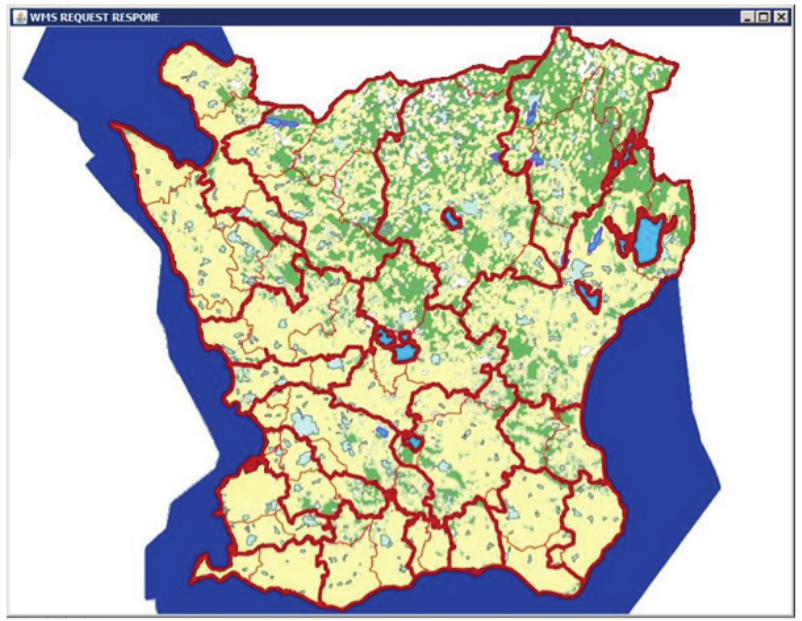
Figure 8: Output from the cartographic enhanced geoportal for the whole study area (province of Sk˚ane). Historical borders are thick dark red lines and municipality borders are thin orange